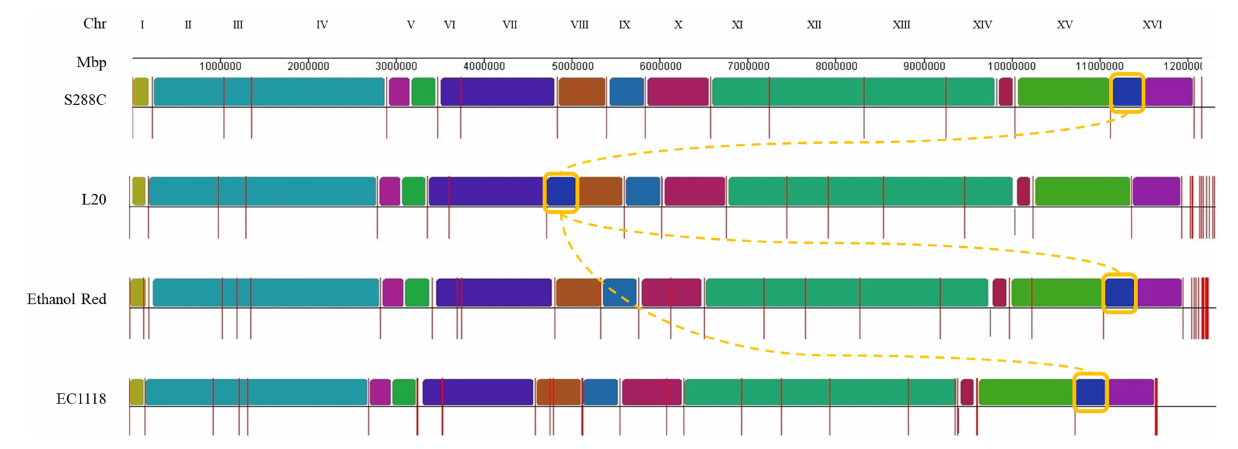
Frontiers in Microbiology |